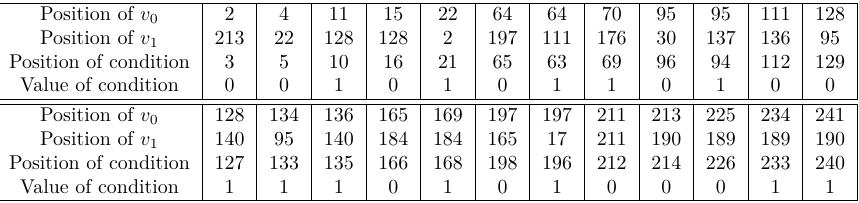
Table 6: Parameters for TYPE-I conditional cube tester